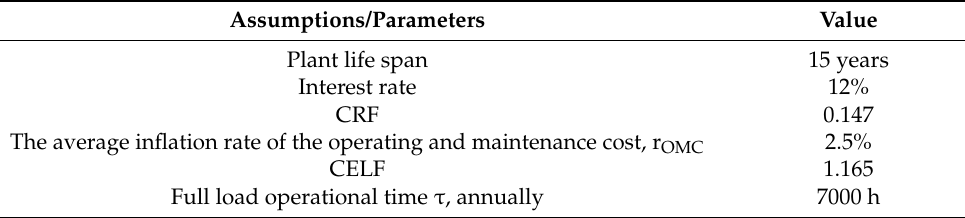
Table 12. Assumptions and parameters of the economic analysis.